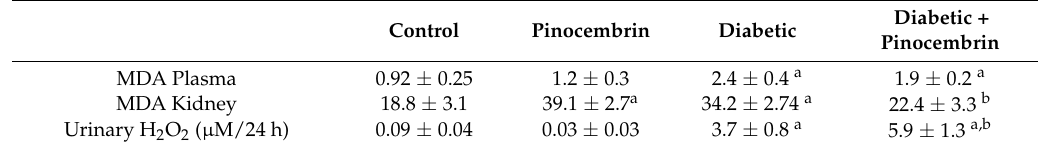
Table 3. Oxidative stress parameters in corrective